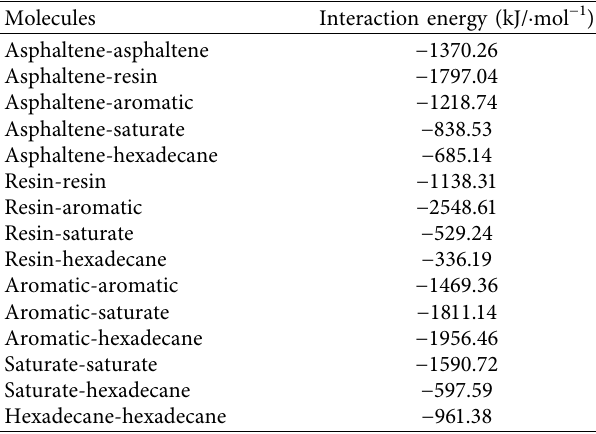
Table 4: Interaction energies of different pairs at